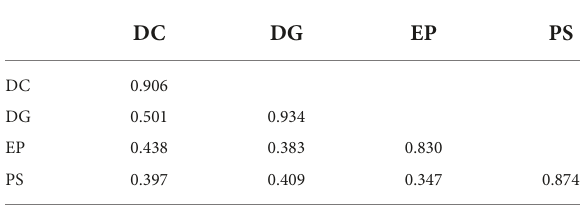
TABLE 3 Fornell–Larcker.